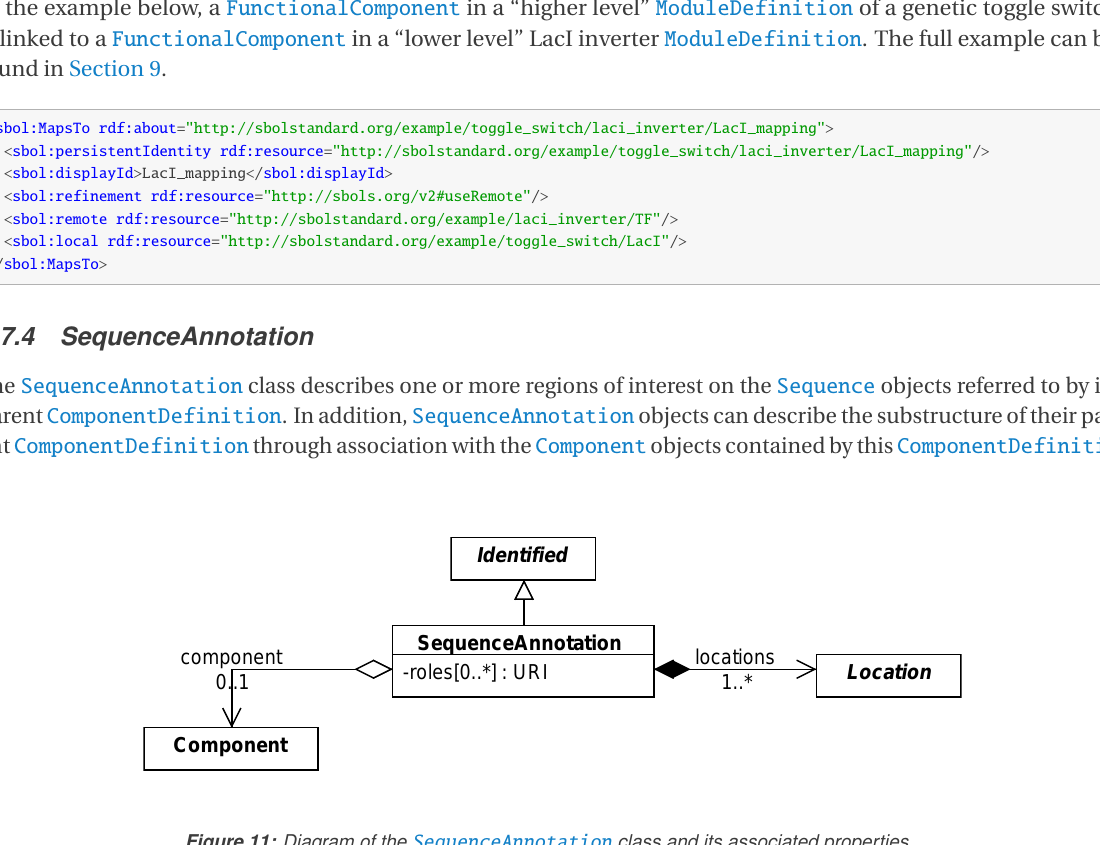
Figure 11: Diagram of the SequenceAnnotation class and its associated